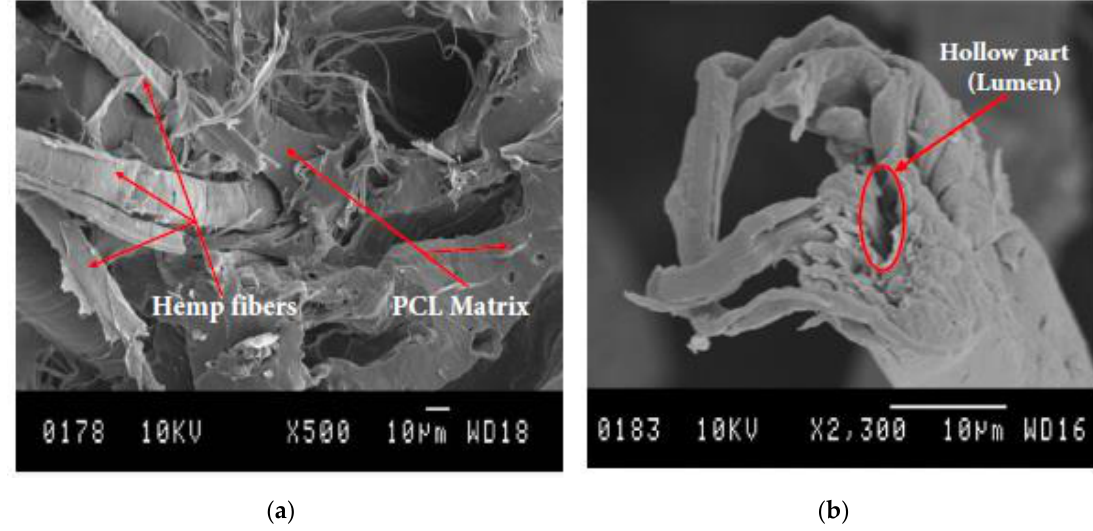
Figure 8. The scanning electron microscope (SEM) micrographs of the ( a ) hemp fiber and PCL matrix and ( b ) morphological structure of the bast fiber element (hemp), showing hollow (lumen).